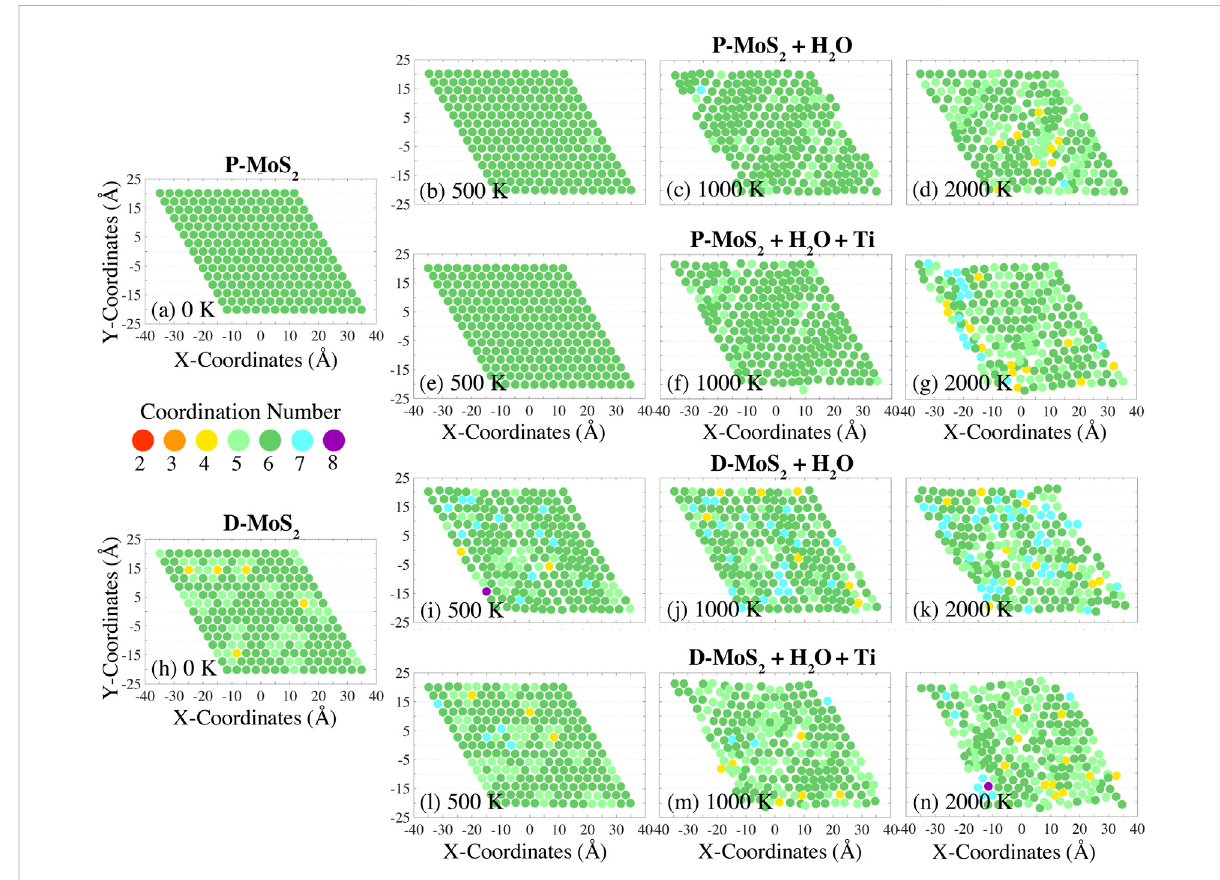
FIGURE 3 Variation of Mo atom coordination numbers during the temperature ramp with a rate of 10 K/ps, for pristine MoS 2 with H 2 O (P-MoS 2 + H 2 O) at (B) 500 K, (C) 1,000 K,and (D) 2,000 K;pristineMoS 2 withH 2 OandTiclusters(P-MoS 2 +H 2 O+Ti)at (E) 500 K, (F) 1,000 K,and (G) 2,000 K;defective MoS 2 with H 2 O (D-MoS 2 + H 2 O) at (I) 500 K, (J) 1,000 K, and (K) 2,000 K; and defective MoS 2 with H 2 O and Ti clusters (D-MoS 2 + H 2 O+ Ti) at (L) 500 K, (M) 1,000 K,and (N) 2,000 K. Thecoordination numbersfor theinitialcon fi gurations(at0 K)ofP-MoS 2 and D-MoS 2 arepresentedin (A) and (H) for